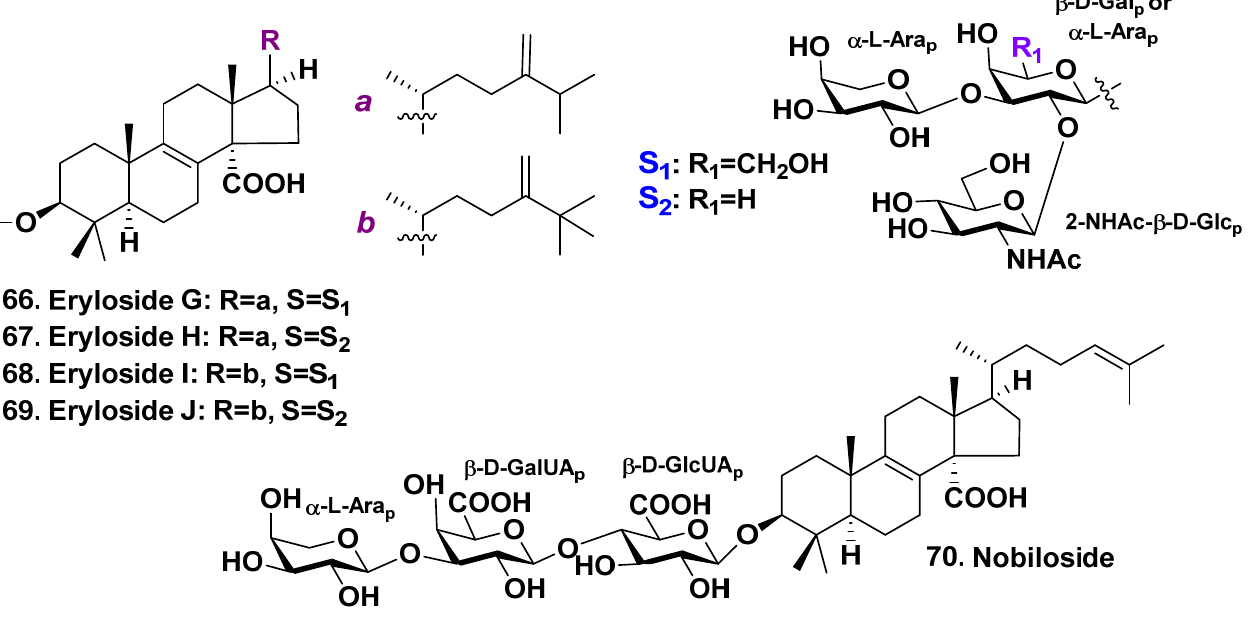
Figure 5. Erylosides 66 – 70 from Erylus nobilis .